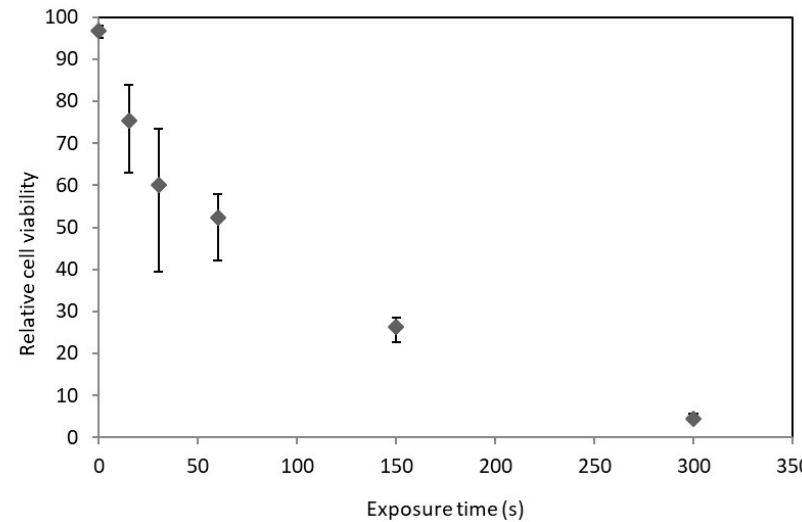
Figure 3. Relative cell viability of D. salina at various exposure times to ultraviolet light in the stationary phase. n = 3. Error bars represent the range. Control at 0 s of irradiation. UVB intensity at 1.5 W/cm 2 . Carried out as in Materials and Methods. Culture densities approximately 0.7 mg/mL dry weight.